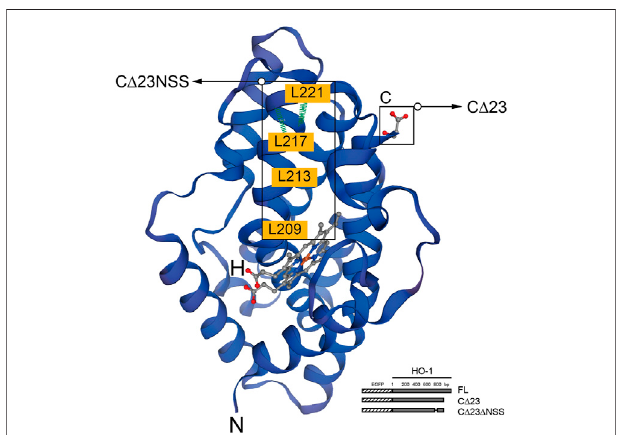
FIGURE1 | Structure ofHO-1protein generated by theSWISS-MODEL tool. The highlighted region is C-terminal, which is critical for protein to be anchored in the smooth endoplasmic reticulum(sER), and the region abundant in leucine homologous to NES motif. The binding domain of heme is marked in red. Schematic representation of HO-1 cDNA obliteration and truncation are shown in the lower right corner. Hatched section, EGFP; solid section, HO-1 cDNA mutants. FL, full-length HO-1 cDNA; C Δ 23, HO-1 cDNA without the C-terminal 23 amino acids; C Δ 23 Δ NSS, HO-1 cDNA without the C-terminal 23 amino acids and the NSS